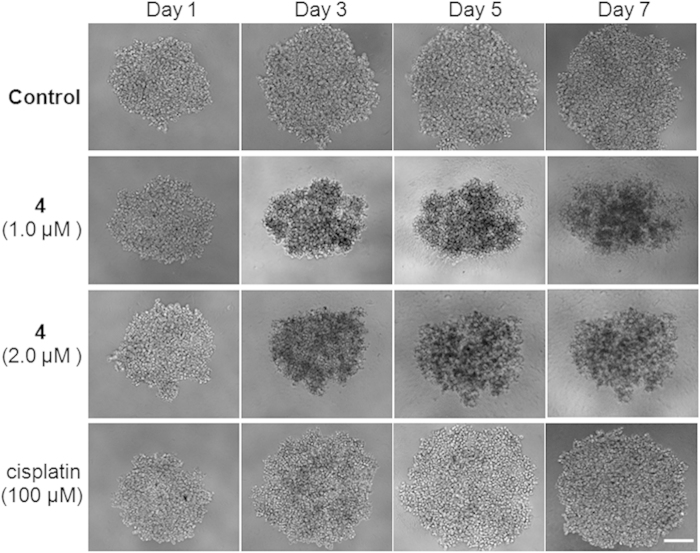
Growth inhibition of drug-treated A549R MCTSs.Scale bar: 200 μm.